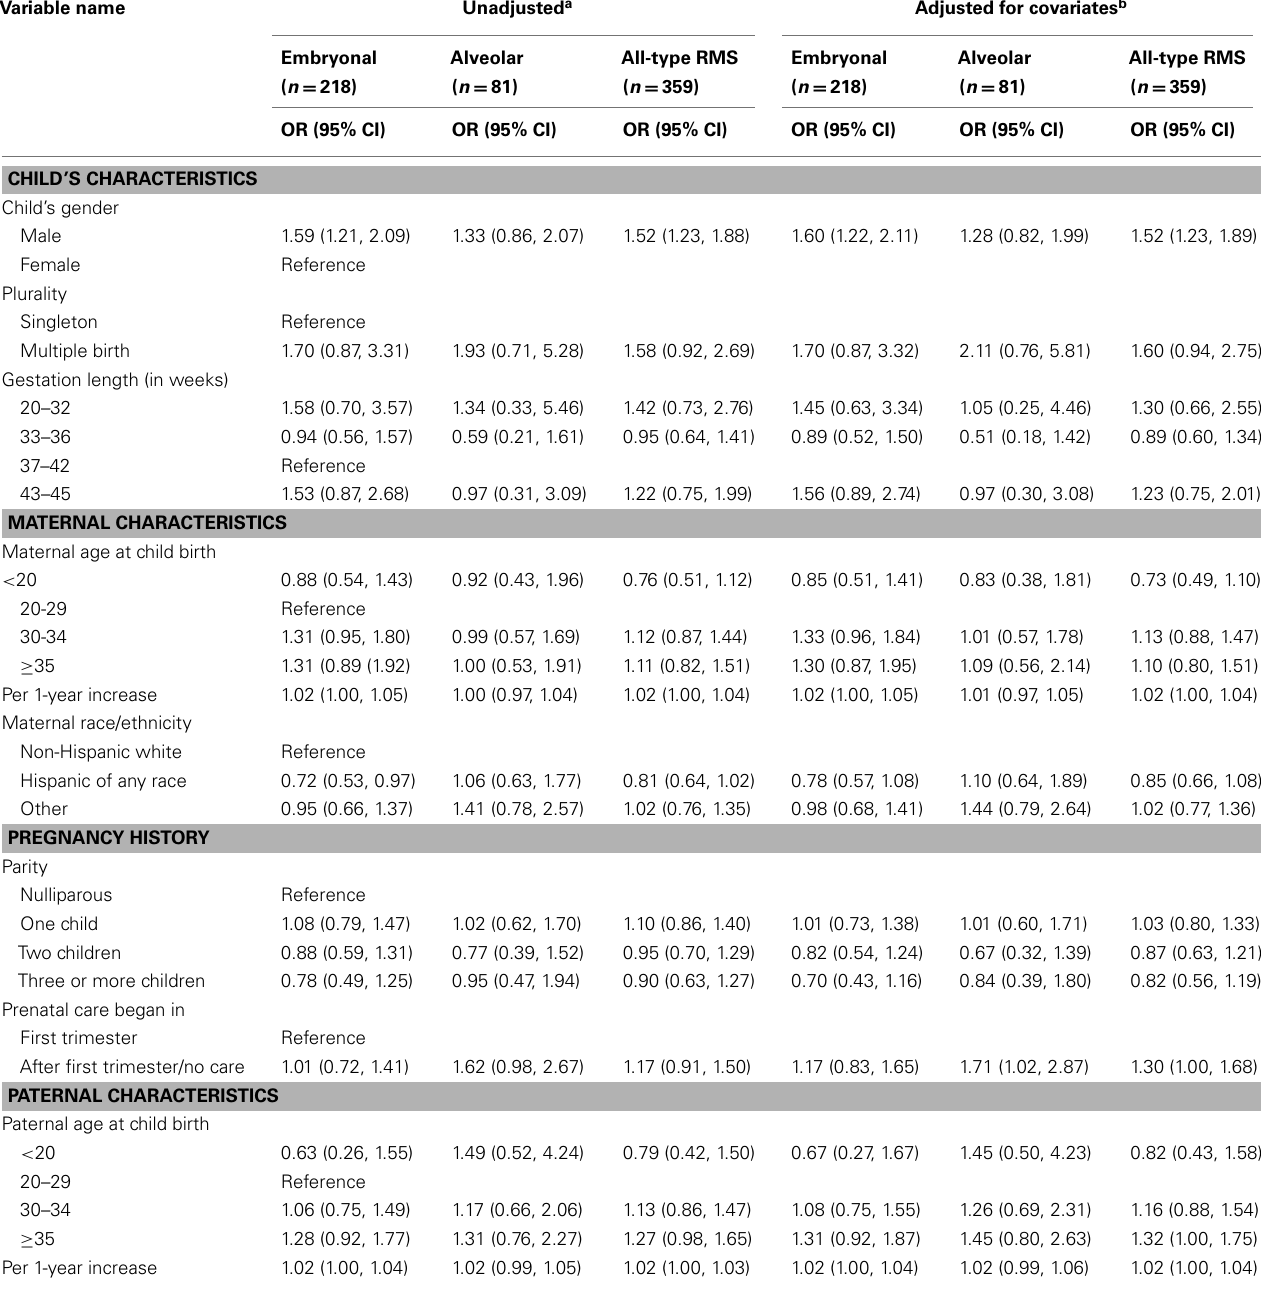
Table 3 | Unadjusted and adjusted logistic regression outcomes for perinatal